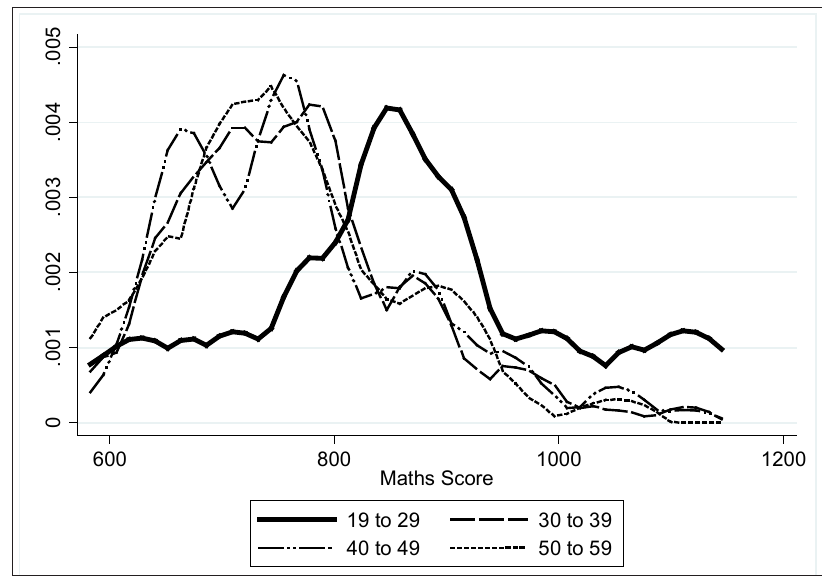
Figure 1: Teacher mathematics score by age group (Source: SACMEQIII 2007) The kernel density curves demonstrate that younger teachers perform at a significantly higher level in the mathematics test than teachers in older age groups. Similar results are obtained with regards to teacher performance on language